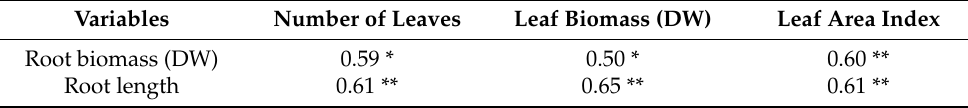
Table 3. Correlation coefficients between root biomass, root length, and yield components.